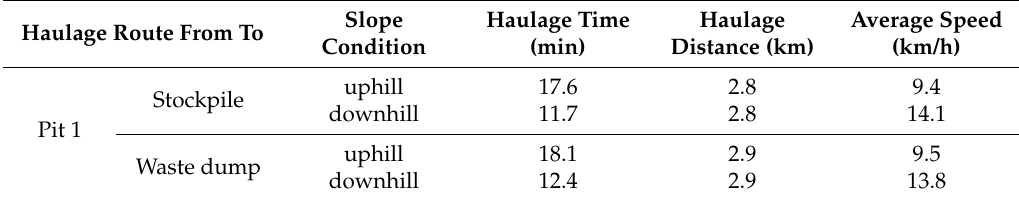
Table 4. Results of estimating the haulage time, haulage distance, and speed of the dump truck according to slope